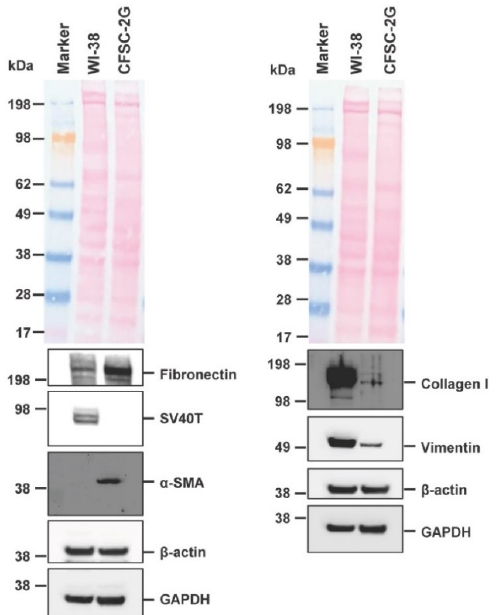
Figure 5. Expression of typical hepatic stellate cell markers in CFSC-2G. Protein extracts were prepared from WI-38 and CFSC-2G cells and analyzed for expression of Fibronectin, Simian virus 40 large T antigen (SV40T), α -smooth muscle actin ( α -SMA), collagen type I, and Vimentin. The membranes were re-probed with antibodies directed against β -actin and GAPDH. In addition, the Ponceau S stains of membranes are shown to document equal protein loading in each lane.